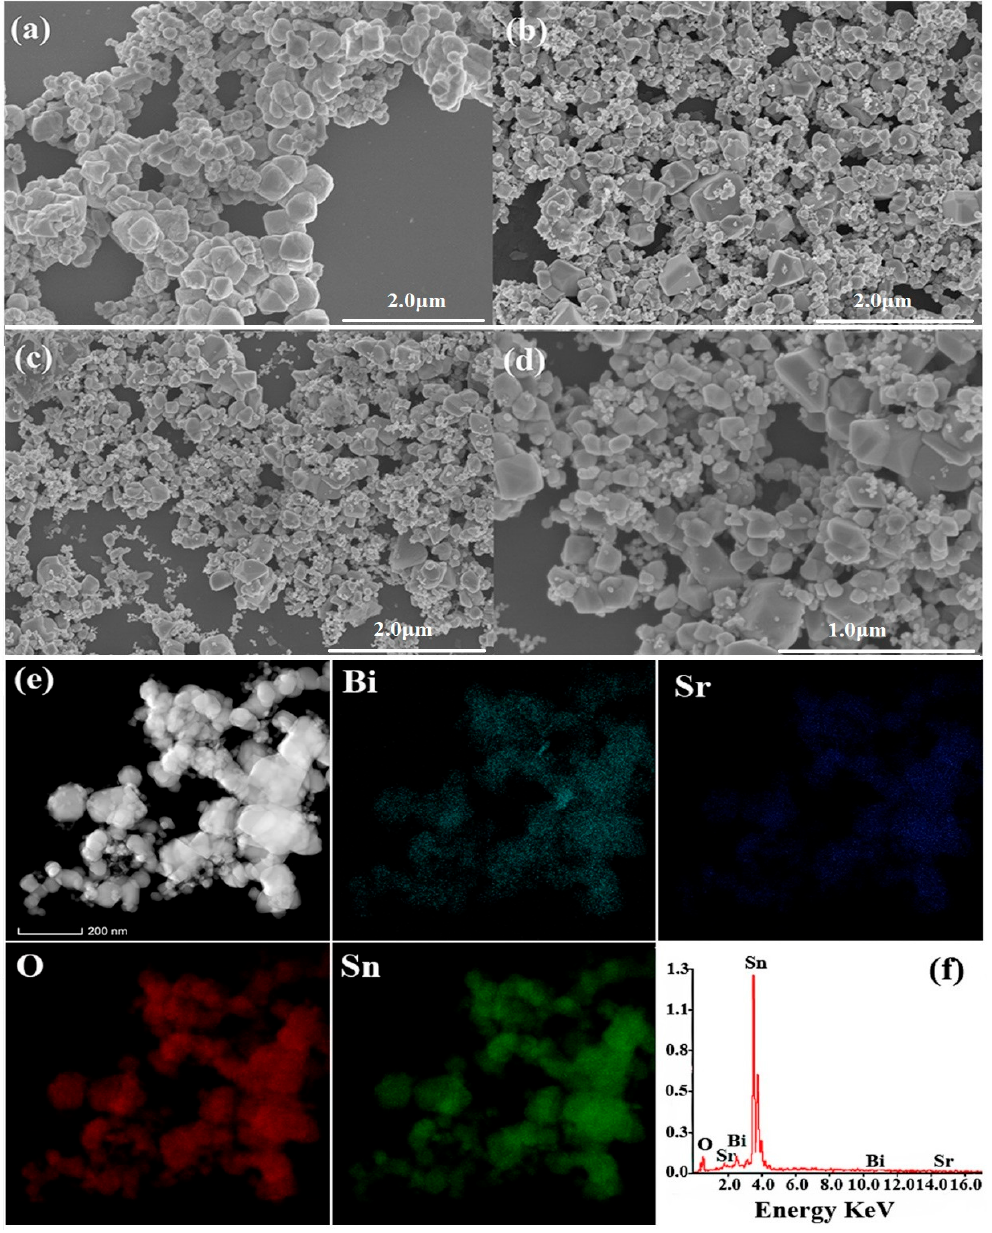
Figure 3. FESEM images of ( a ) SBO, ( b ) SnO 2 , ( c ) and ( d ) 14 wt% SBO/SnO 2 composite, ( e )Energy Dispersive Spectrometer (EDS) elemental mapping and ( f ) EDS spectrum of 14 wt% SBO/SnO 2 composite.